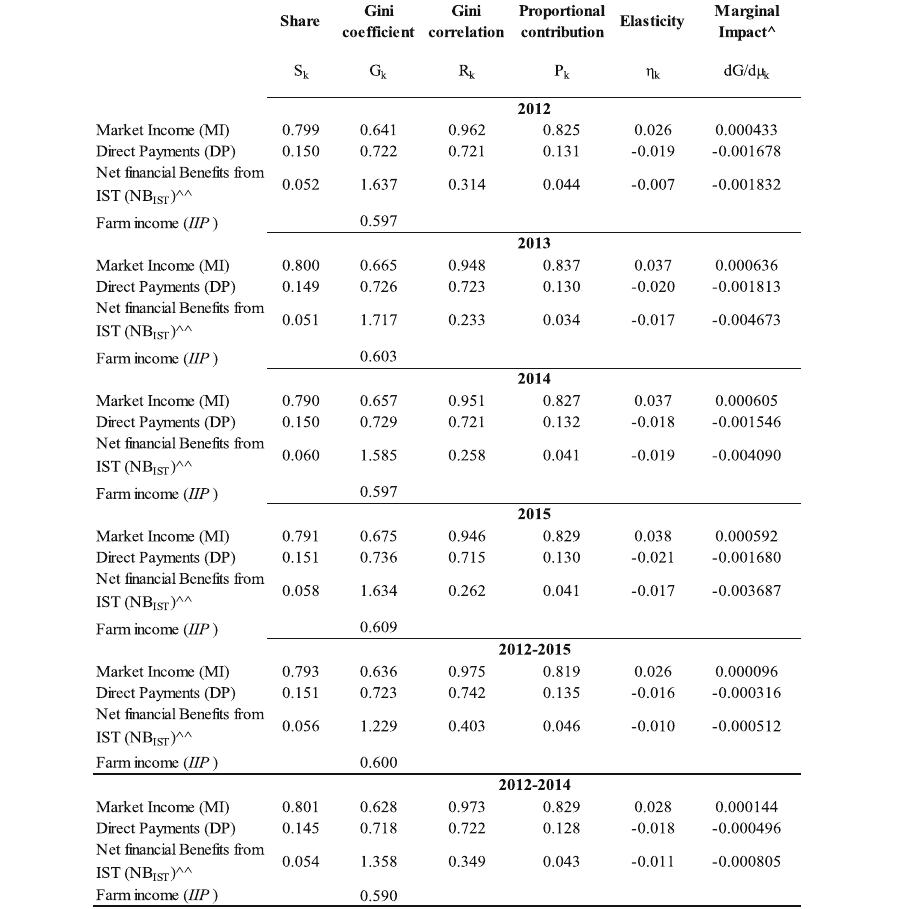
Table 11 Gini decomposition by income sources with transaction cost. All farm sample, years from 2012 to 2015, and whole periods 2012 – 2015 and 2012 – 2014. Transaction costs set at 20% of the